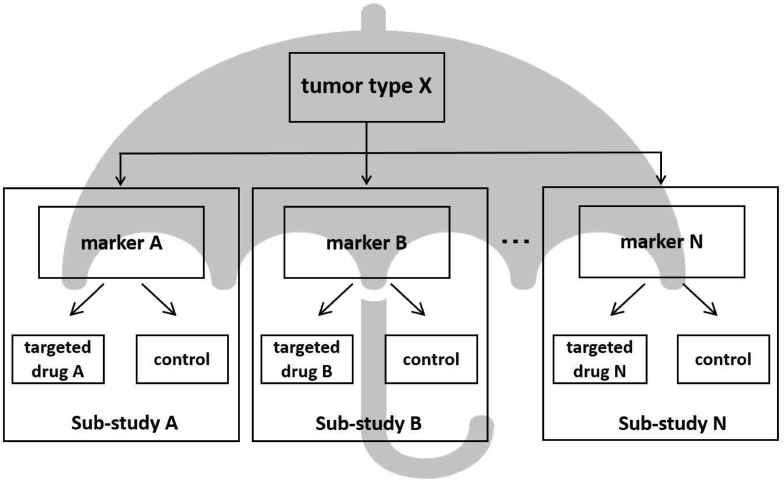
Umbrella trials.